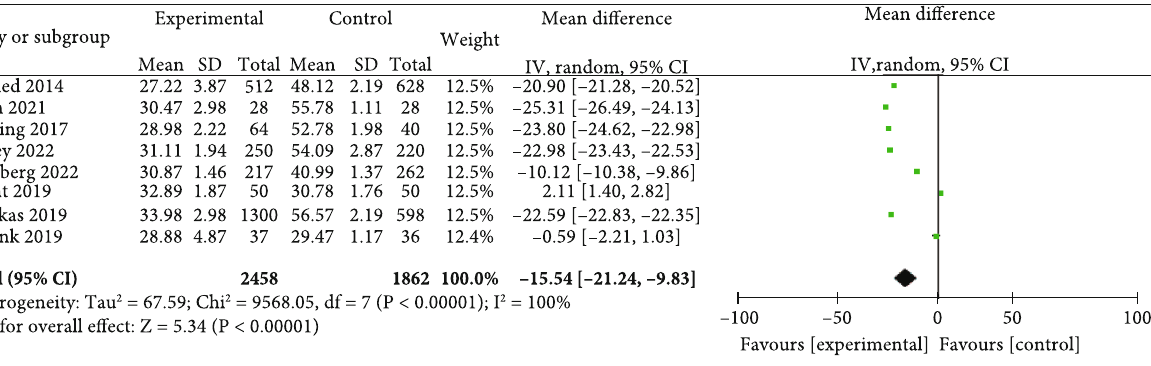
Figure 4: E ffi cacy of high-quality nursing on extubation time. P < 0 : 00001 , ∗∗∗ . With heterogenity 67.59, Chi 2 = 9568 : 05 , df = 7 , I 2 = 100